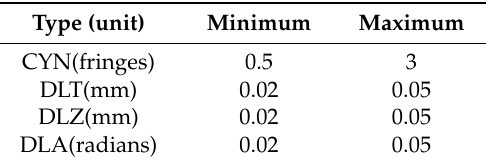
Table 4. Tolerance